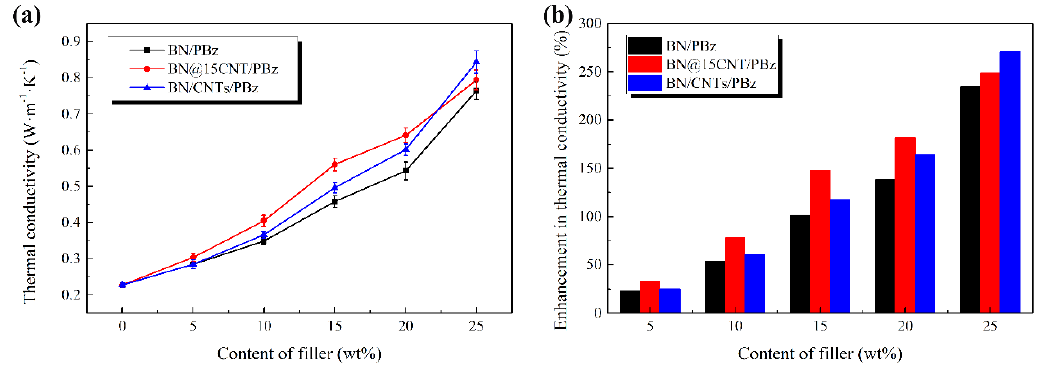
Figure 8. ( a )Thermal conductivity of the PBz composites with different content of BN@15CNT